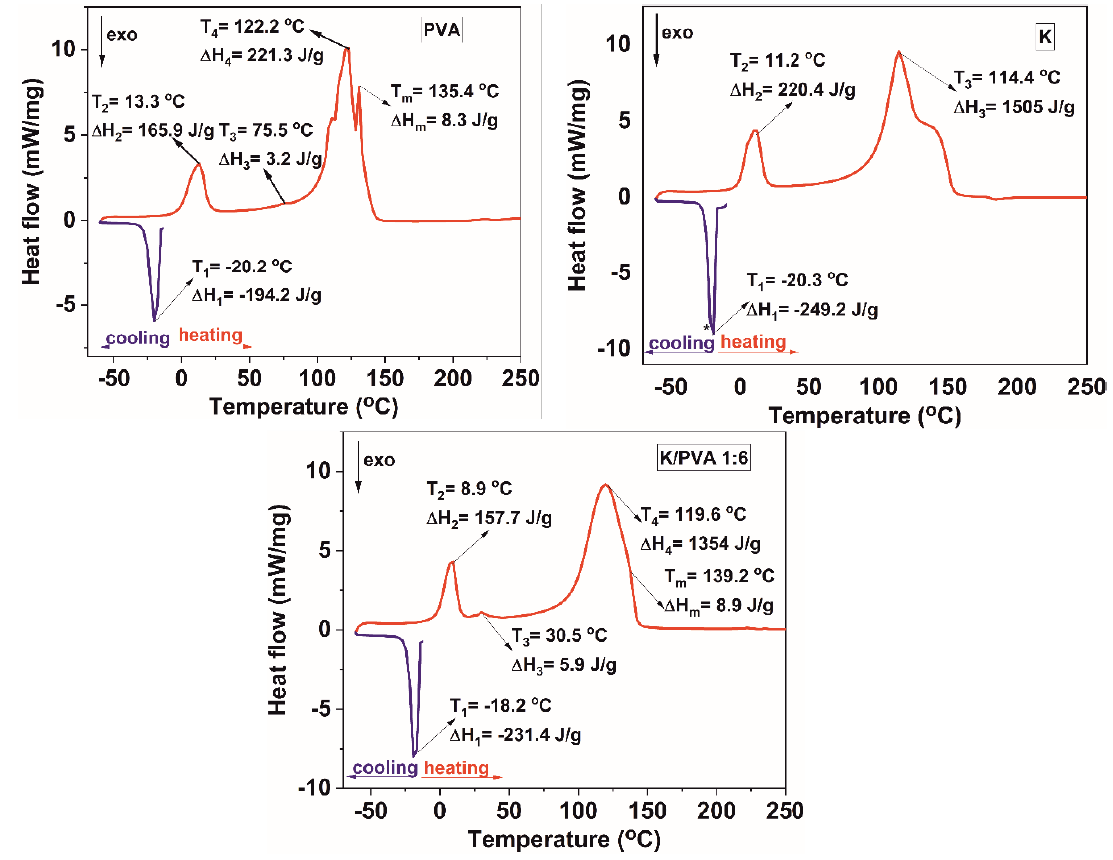
Figure 7. DSC thermograms of the obtained hydrogels.